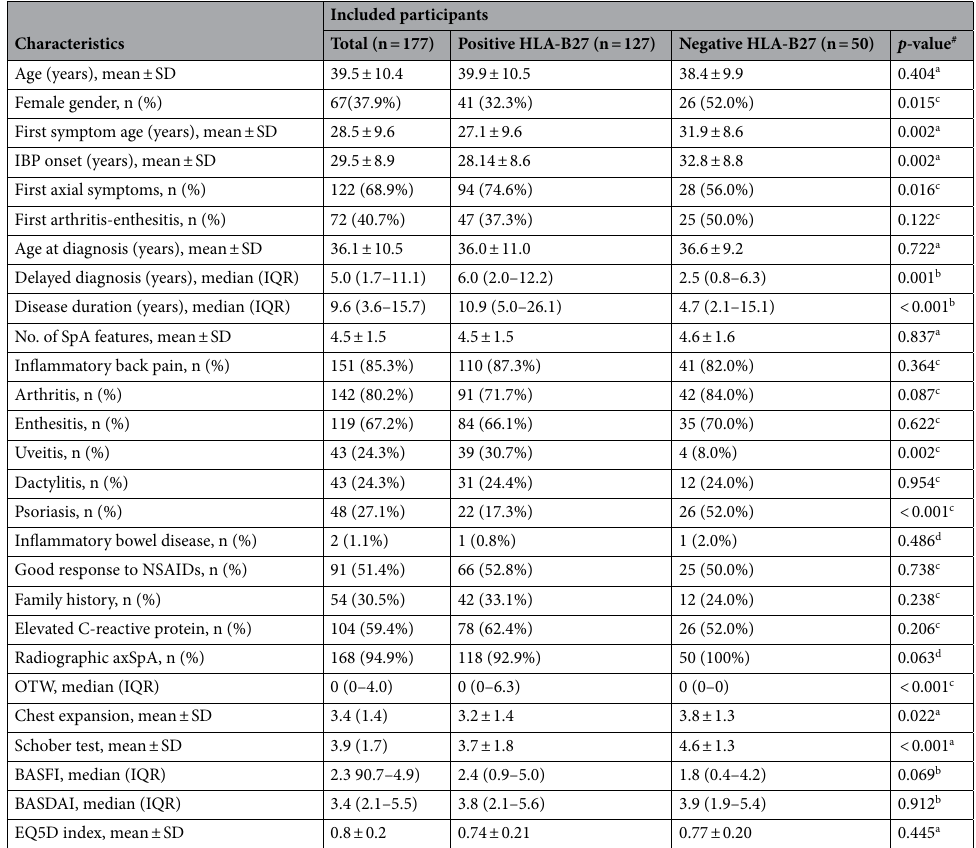
Table 1. Characteristics of axial spondyloarthritis participants compared between included participants with positive and negative HLA-B27 status. BASDAI Bath Ankylosing Spondyloarthritis Disease Activity Index, BASFI Bath Ankylosing Spondylitis Functional Index, EQ-5D index EuroQoL 5 ‐ dimension 5 ‐